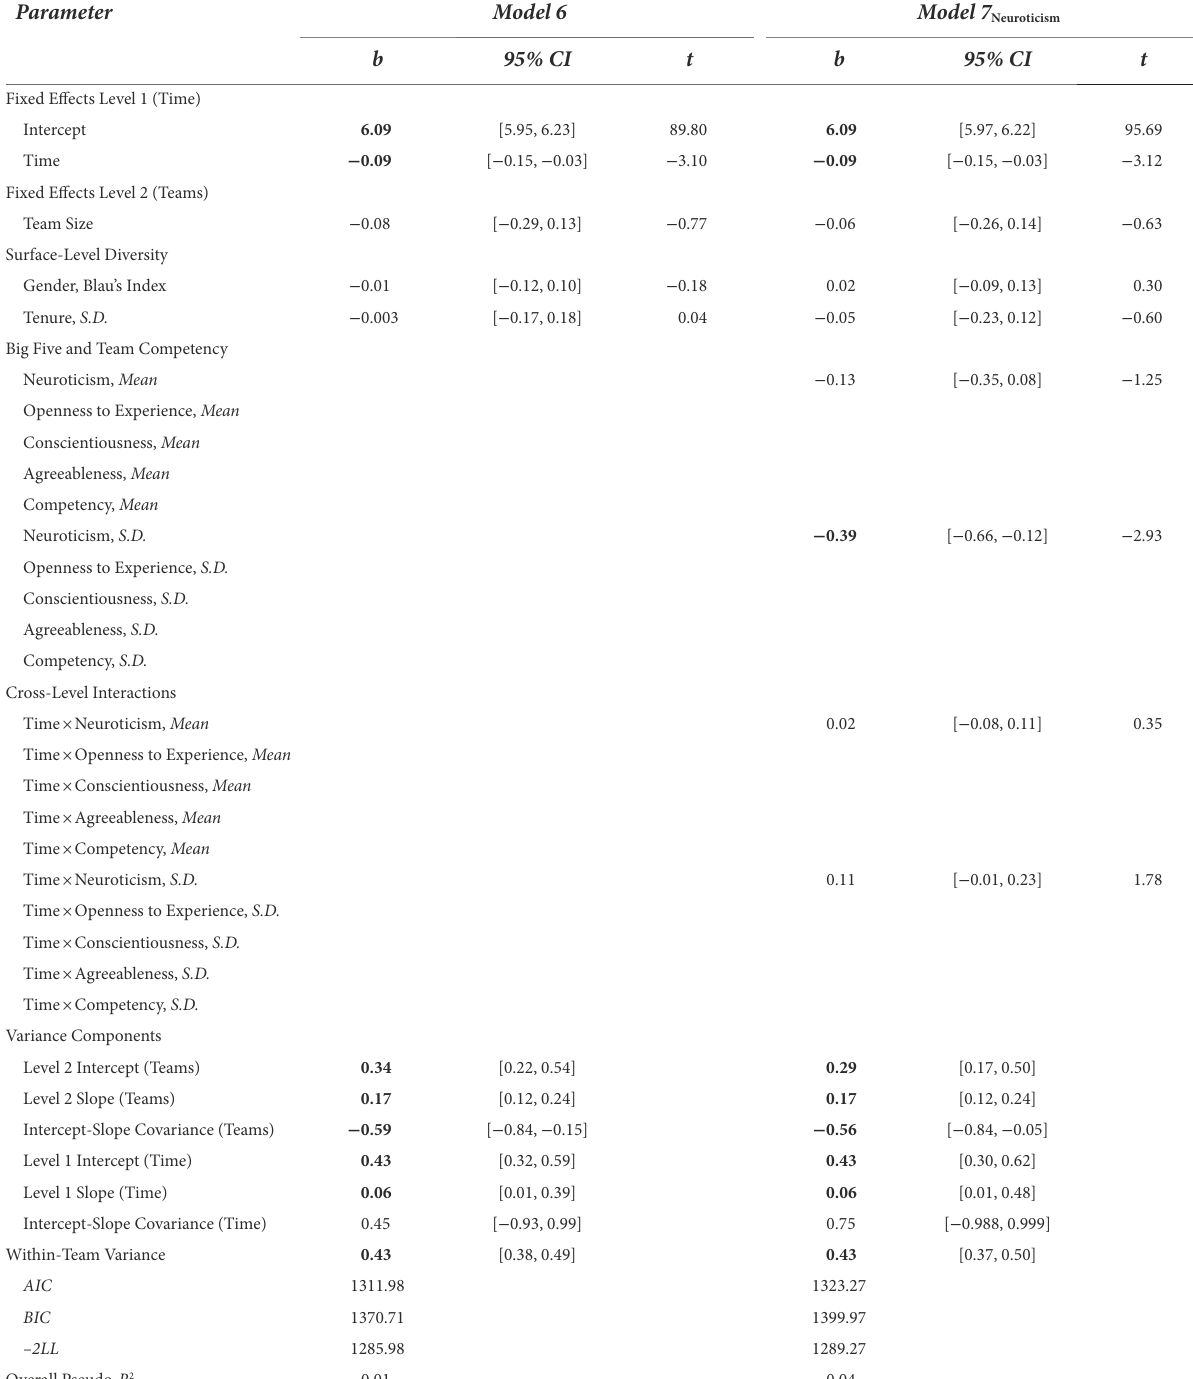
TABLE 3 Linear Growth Curve Model ( n = 699 measurements nested in three time points, in 233 members in 61 teams) for changes in team psychological safety predicted by team personality and competency (Models 6 and 7).